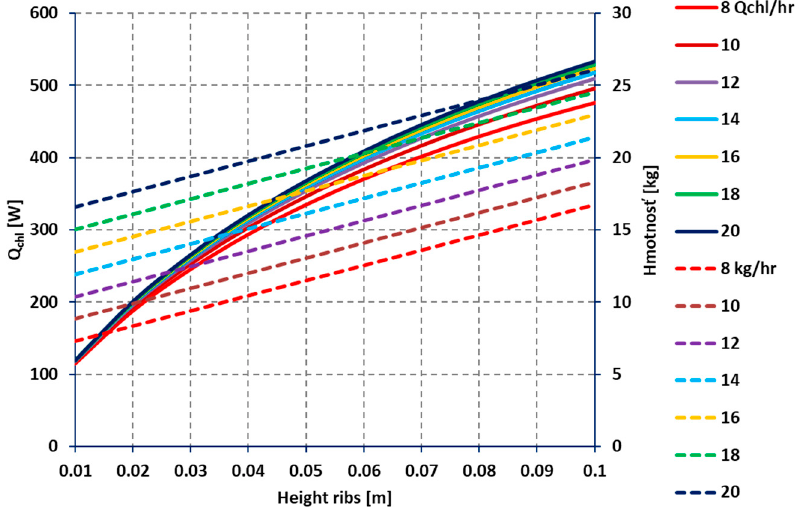
Figure 5. Power of cooling beam PDK-F depending on the number of tubes, the height of the rib and its weight.